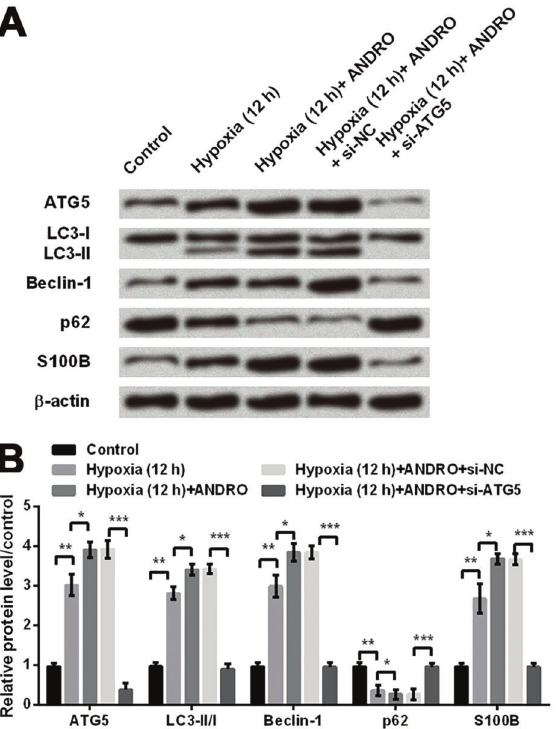
Figure 6. A , Protein immunoblots of ATG5, S100B, and autophagy-related proteins measured by western blot in hypoxic astrocytes with or without si-ATG5 transfection and treatment of andrographolide (ANDRO). B , Relative expressions of ATG5, S100B and autophagy-related proteins by quanti fi cation of band intensity. b -actin acted as an internal control. si-NC: non-targeting siRNA. Data are reported as means ± SD. *P o 0.05, **P o 0.01, ***P o 0.001